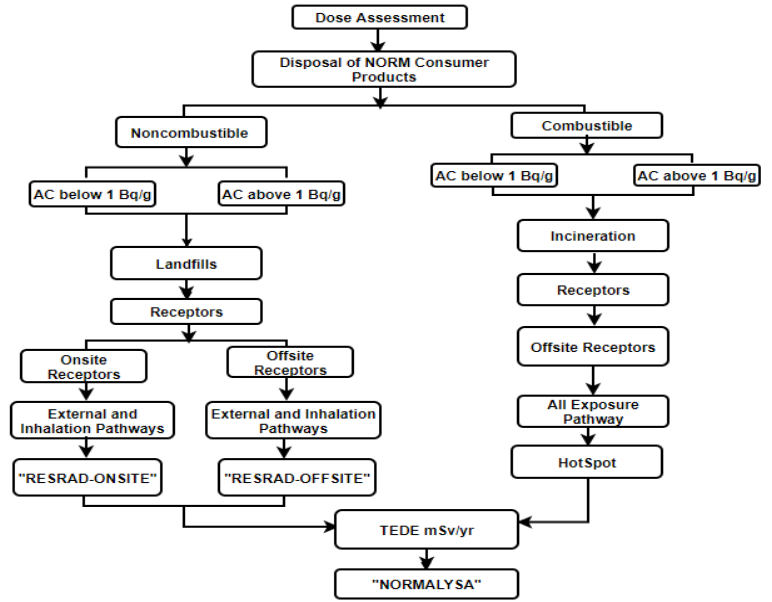
Figure 2. Summary of the scenario for the disposal of consumer products containing naturally occurring radioactive materials.